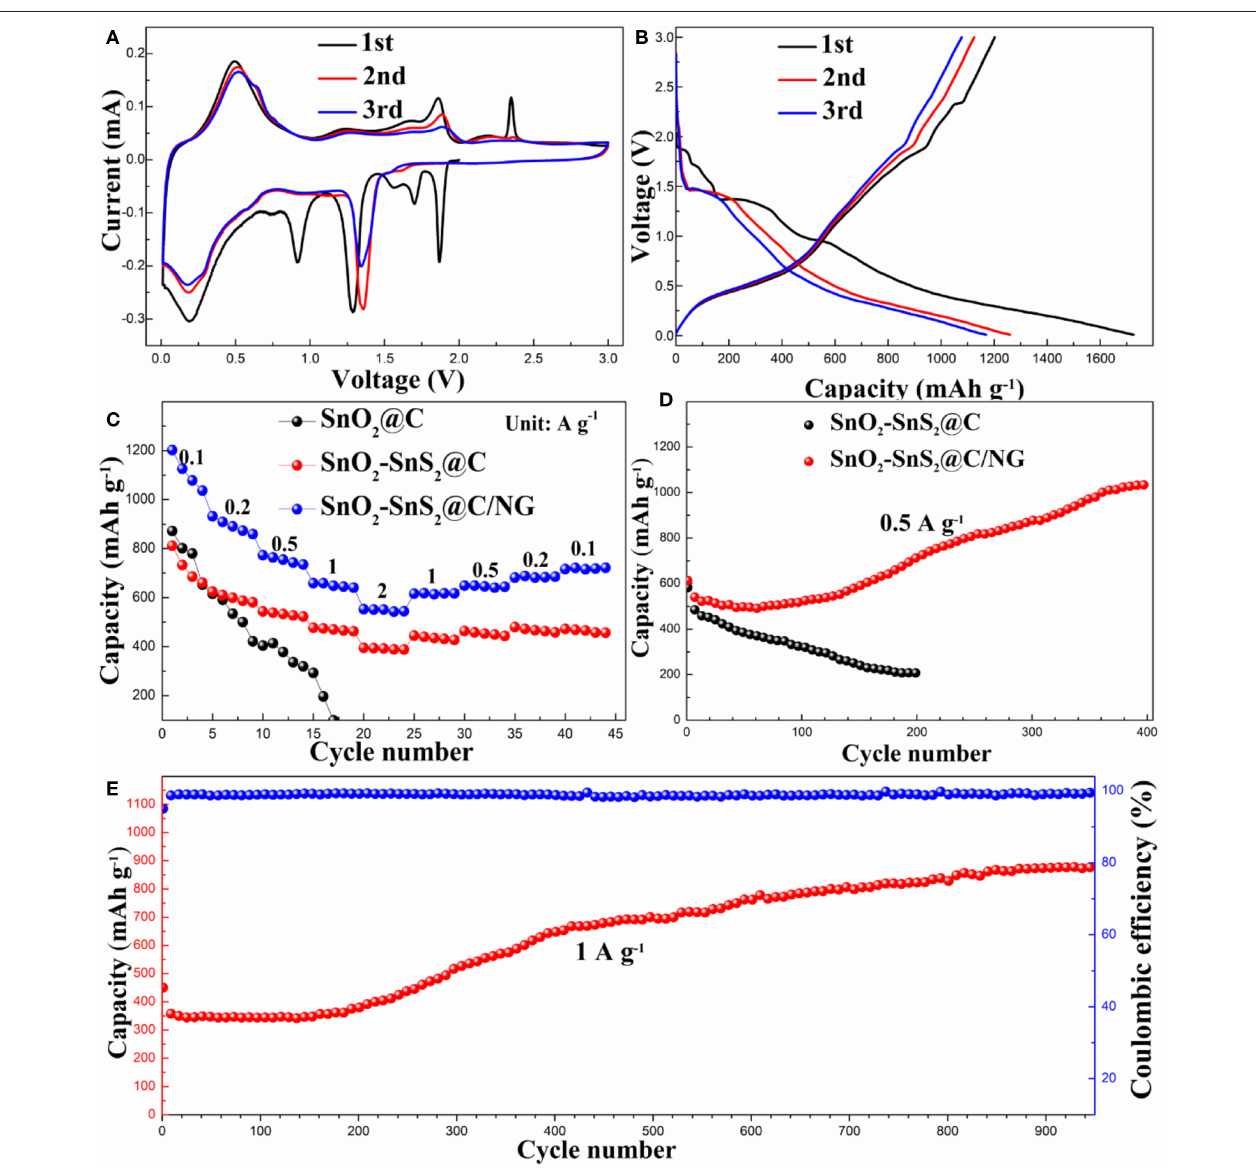
FIGURE 5 | (A) CV profiles and (B) the charge/discharge curves in the initial three cycles for SnO 2 -SnS 2 @C/NG composite. (C) Rate capabilities and (D) cycle performances for SnO 2 -SnS 2 @C and SnO 2 -SnS 2 @C/NG composites at current rate of 0.5A g − 1 , and (E) long cycling property for SnO 2 -SnS 2 @C/NG composite at current rate of 1A g − 1